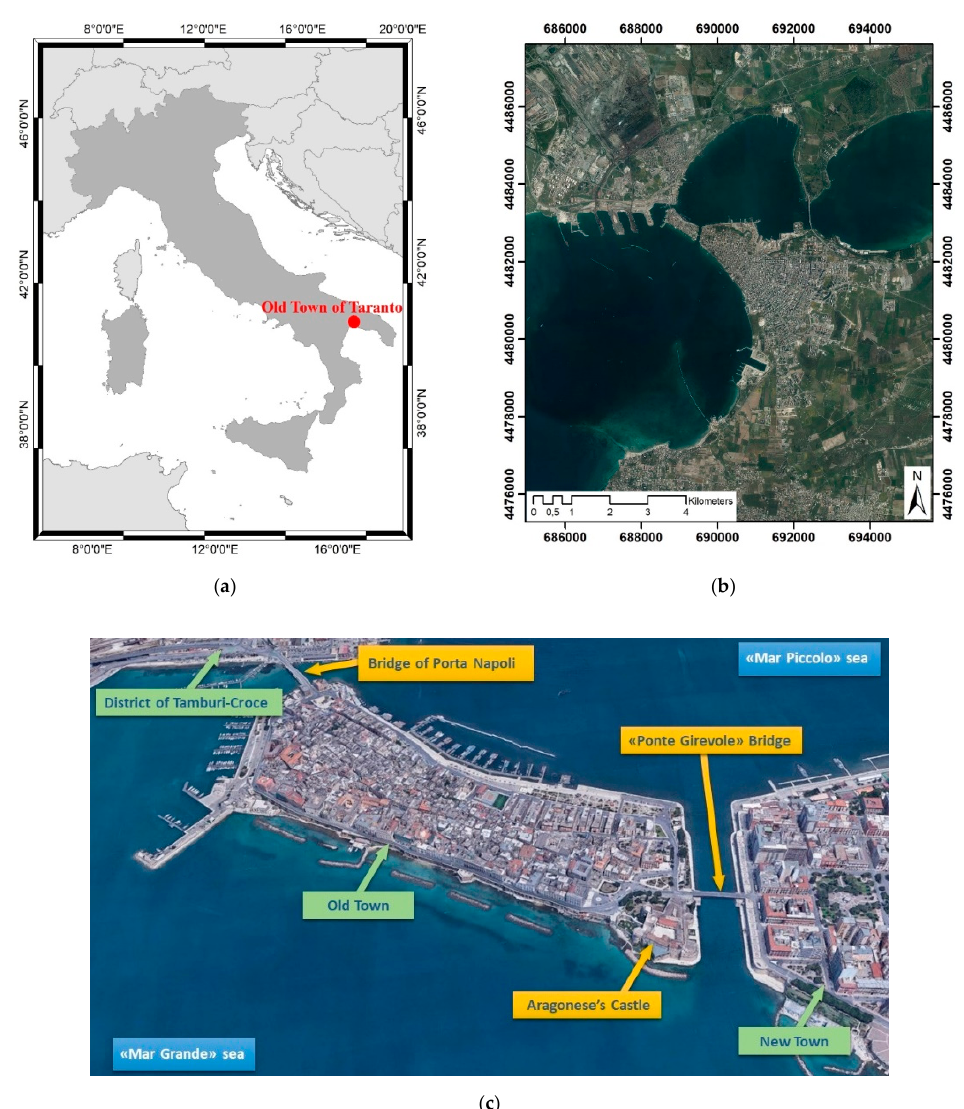
Figure 2. The study area: ( a ) location; ( b ) orthophoto in UTM33-WGS84 of the Taranto city; ( c ) Figure2. Thestudyarea: ( a )location; ( b )orthophotoinUTM33-WGS84oftheTarantocity; ( c )panoramic panoramic image of the old town of Taranto. image of the old town of